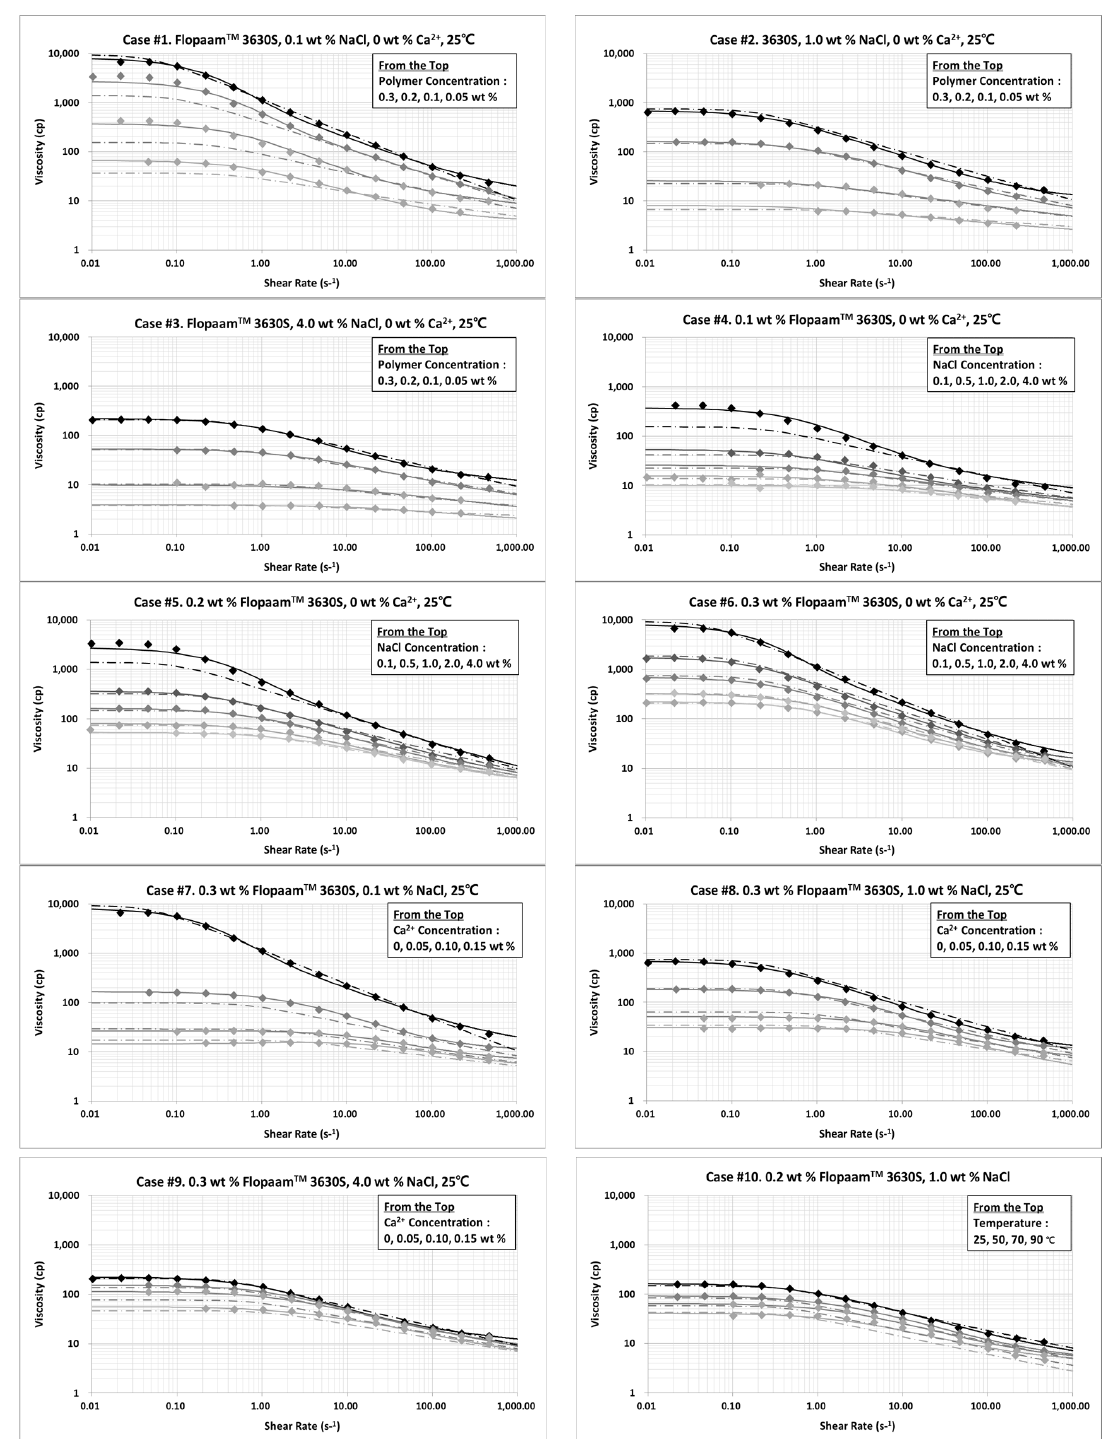
Figure 8. Comparison between the measured and estimated viscosities of Flopaam TM 3330S. Line, viscosity estimated by the ANN model; dot, measured viscosity; dotted line, viscosity estimated by the Carreau model using Lee’s correlation.